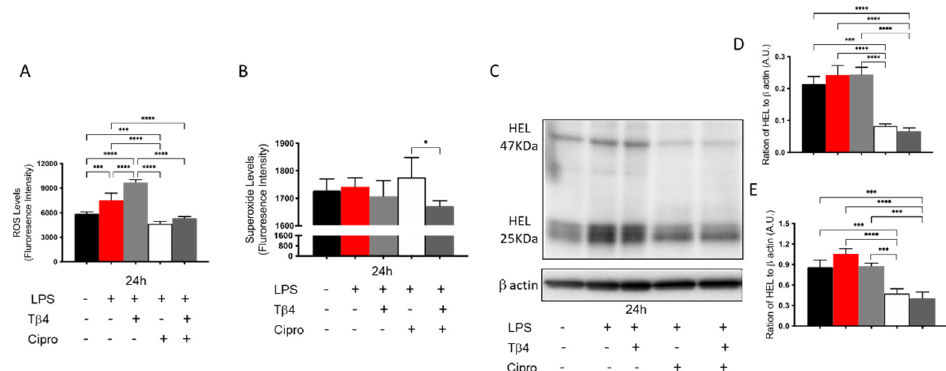
Figure 4. In vitro assessment of ROS, superoxide production, and lipid peroxidation in peritoneal- isolated PMN following 24 h of LPS stimulation. For ROS ( A ) and superoxide ( B ) assessments, results are presented as mean fluorescence intensity ± SD of three independent experiments in triplicate. Lipid peroxidation damage as determined by HEL adduct formation ( C ) was assessed by Western blot. Densitometric analysis of HEL adducts formed at approximately 47 kDa ( D ) and 25 kDa ( E ). Data shown are representative of three independent experiments and normalized to β -actin ± SD. n = 3; * p < 0.05; *** p < 0.001; and **** p < 0.0001.